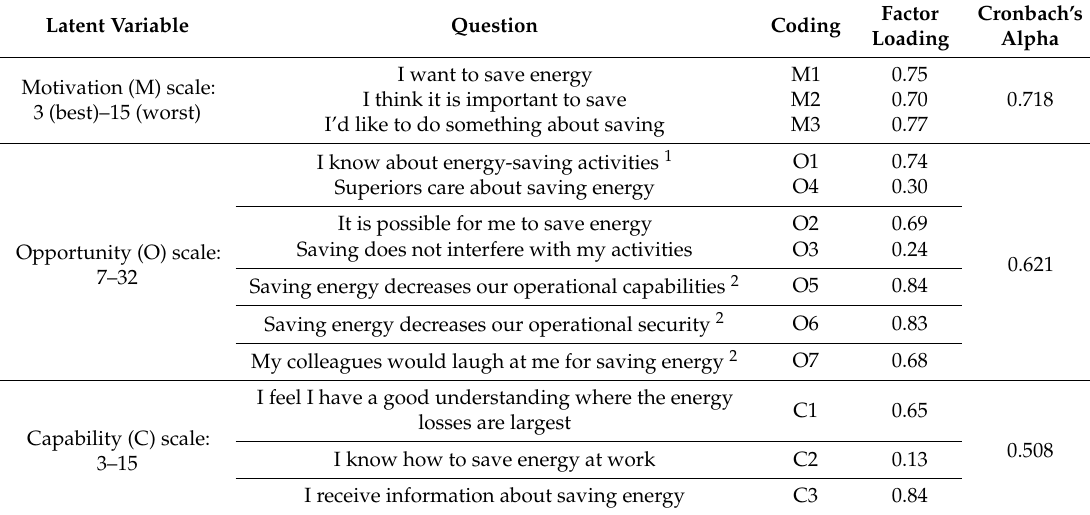
Table 2. Variables and their corresponding questions of the COM-B questionnaire.